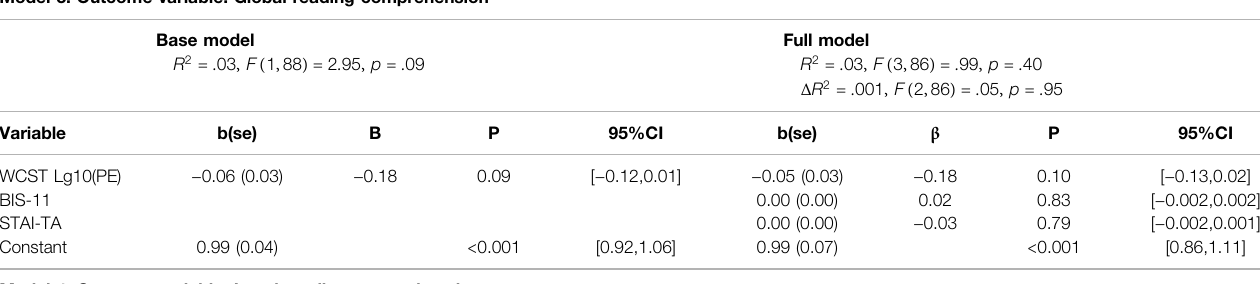
TABLE 3 | Hierarchical regression model with globalreadingcomprehension and local reading comprehension asthe outcome variables and cognitive fl exibility, impulsivity, and anxiety as independent variables. Model 3: Outcome variable: Global reading comprehension Base